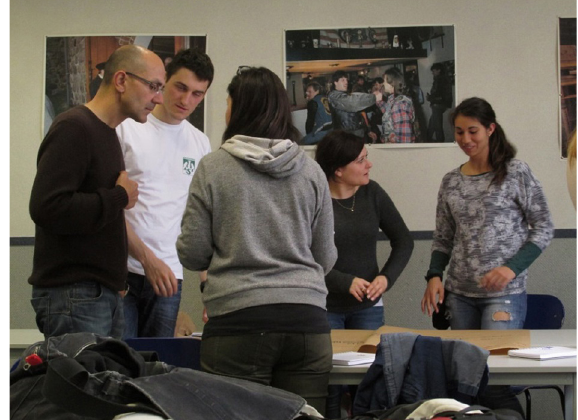
Fig. 1. Students during brainstorming. Josep Vila Subirós as a supervisor; Coll. Pollonicum, Słubice (Photo I. Markuszewska, 2014).